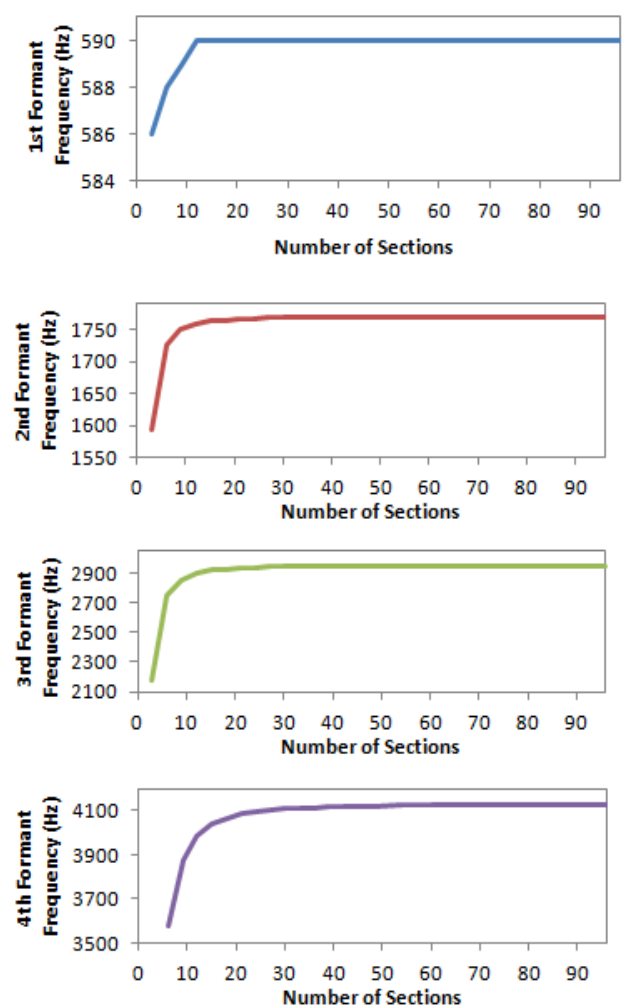
Figure 1. Accuracy of formant frequency calculation with number of sections (spatial discretization) along the vocal tract [2].